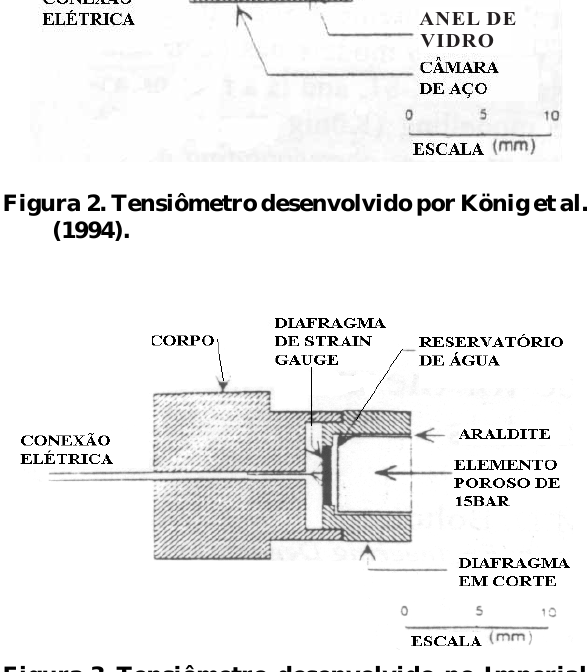
Figura 3. Tensiômetro desenvolvido no